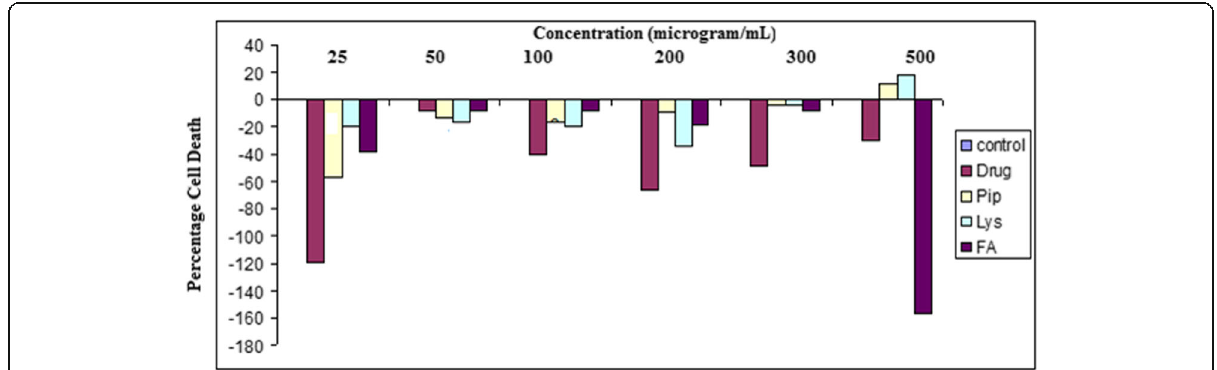
Fig. 2 Bar-graph between Percentage cell death vs. Concentration ( μ g/mL) shows that neither the drug silymarin nor any of the bioenhancers appeared to be cytotoxic on MCF-7 cells over the concentration range of 25 – 500 μ g/mL control. Table 1 indicates different degrees of hepatopro-